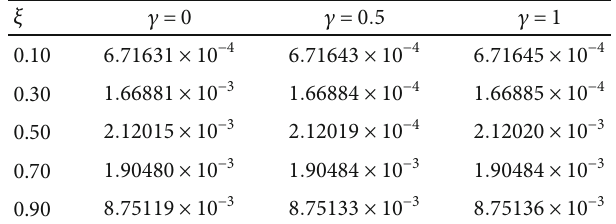
Table 2: The numerical display of error of Example 1 when N = 50 ,